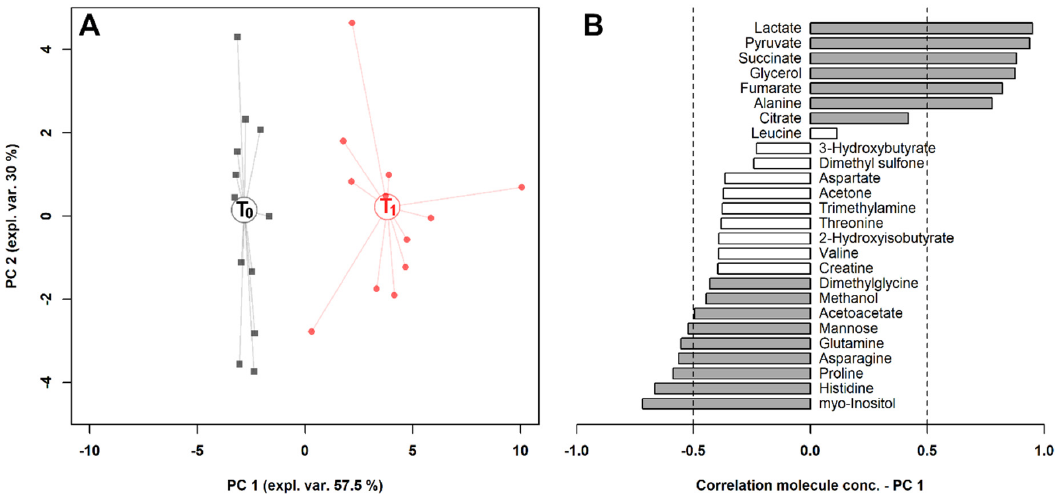
Figure 3. rPCA model built on the space constituted by the concentration of the molecules significantly different in serum, listed in Table 1. ( A ) In the score plot, samples collected at T 0 and T 1 are represented with black squares and red circles, respectively. The wide, empty circles represent the median of the groups. ( B ) The loading plot reports the correlation between the concentration of each substance and its importance over principal component (PC) 1. Significant correlations ( p < 0.05) are highlighted with gray bars.